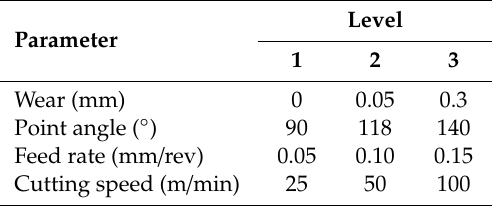
Table 2. Mechanical parameters of the CFRP laminate.